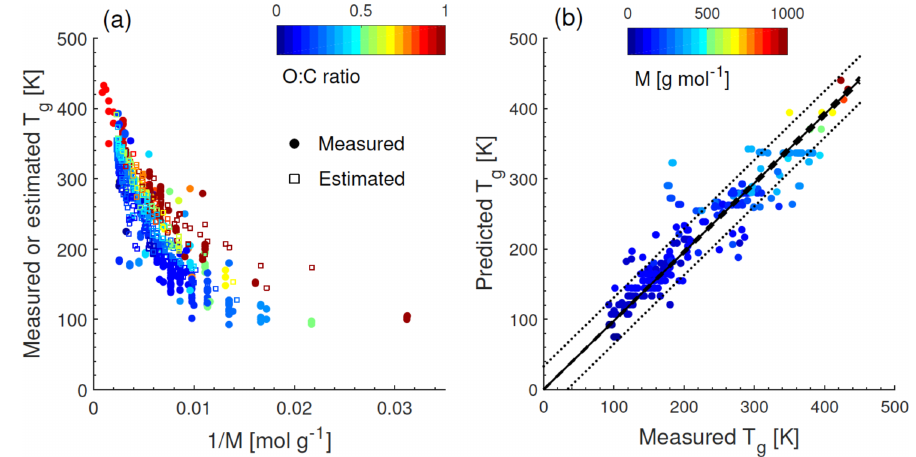
Figure A1. (a) T g of organic compounds as measured (circles) and estimated with the Boyer–Kauzmann rule (squares) plotted against the inverse molar mass. The markers are color coded by atomic O:C ratio. (b) Predicted T g for CHO compounds using a parameterization (Eq. 2) developed in this study compared to measured T g (circles). The solid line shows the 1 : 1 line and the dashed and dotted lines show 68% confidence and prediction bands,